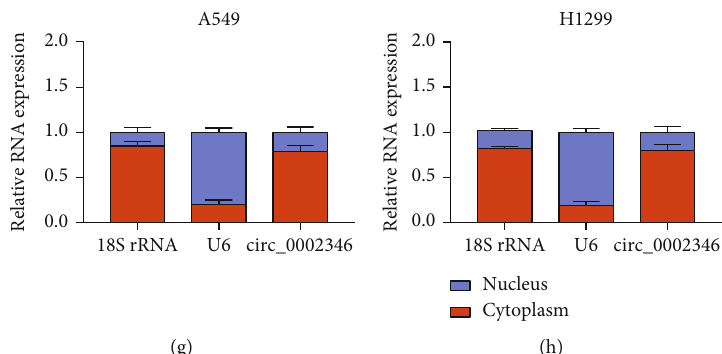
Figure 1: circ_0002346 expression is downregulated in NSCLC tissues and cell lines. (a) The expression level of circ_0002346 was examined in 45 pairs of NSCLC tissues and paracancer tissues by RT-qPCR. (b) RT-qPCR was conducted to measure the level of circ_0002346 in the NSCLC cell lines (A549 and H1299) and the HBE cell line. (c) A schematic diagram of the genomic location and structural composition of circ_0002346 was shown. (d) The existence of circ_0002346 and CRIM1 from cDNA and gDNA was veri fi ed by PCR using the divergent and convergent primers, respectively. (e, f) The RNase R resistance of circ_0002346 and its host gene CRIM1 mRNA was analyzed by RT-qPCR. (g, h) The subcellular localization of circ_0002346 was analyzed, and 18S rRNA and U6 served as cytoplasmic and nuclear markers, respectively. ∗∗∗ P < 0 : 001